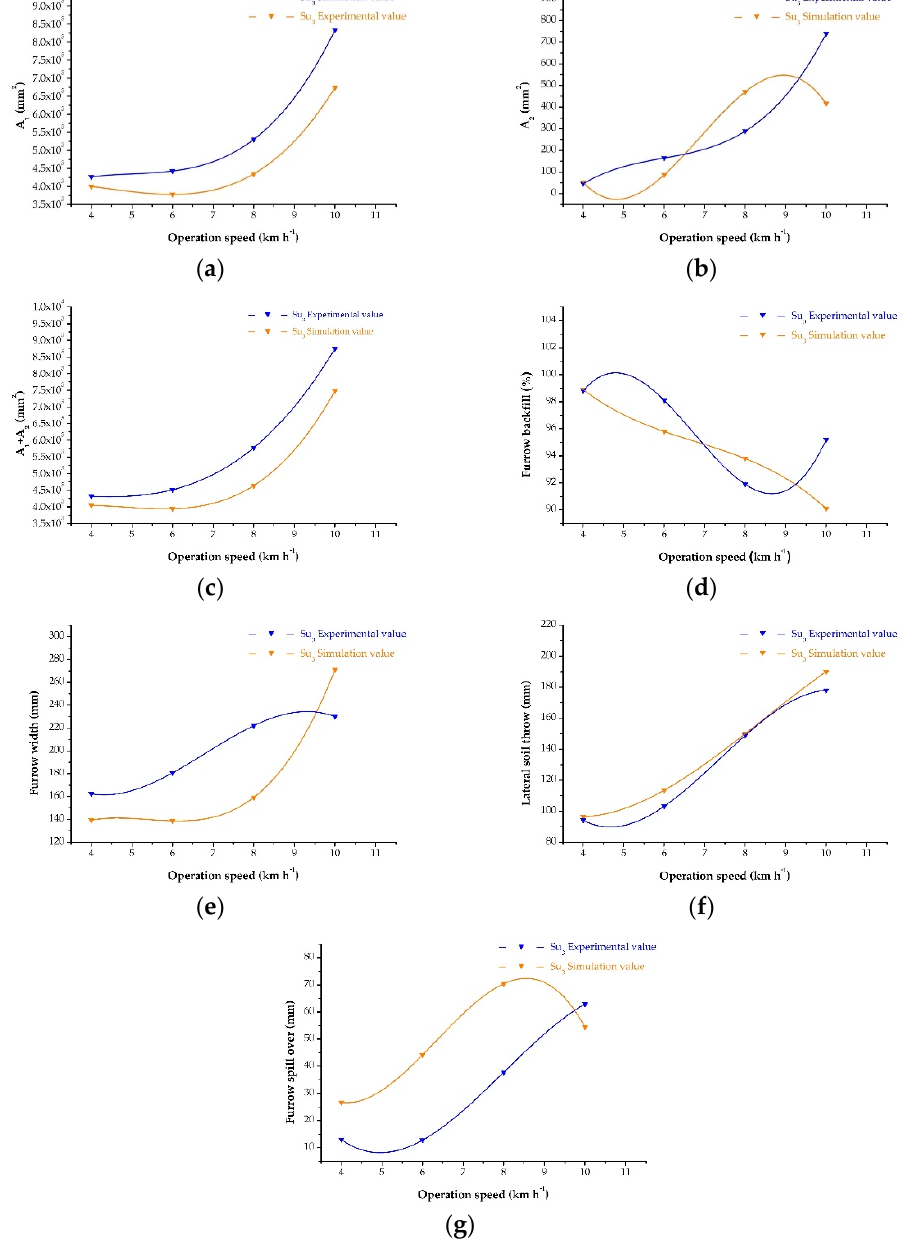
Figure 19. Comparison of Su 3 furrow profile parameters predicted by the discrete element test model at 80 mm operating depth and each operating speed condition. ( a ) A 1 ; ( b )A 2 ; ( c ) A 1 + A 2 ; ( d ) Furrow backfill; ( e ) Furrow width; ( f ) Lateral soil throw; ( g ) Furrow spill over.